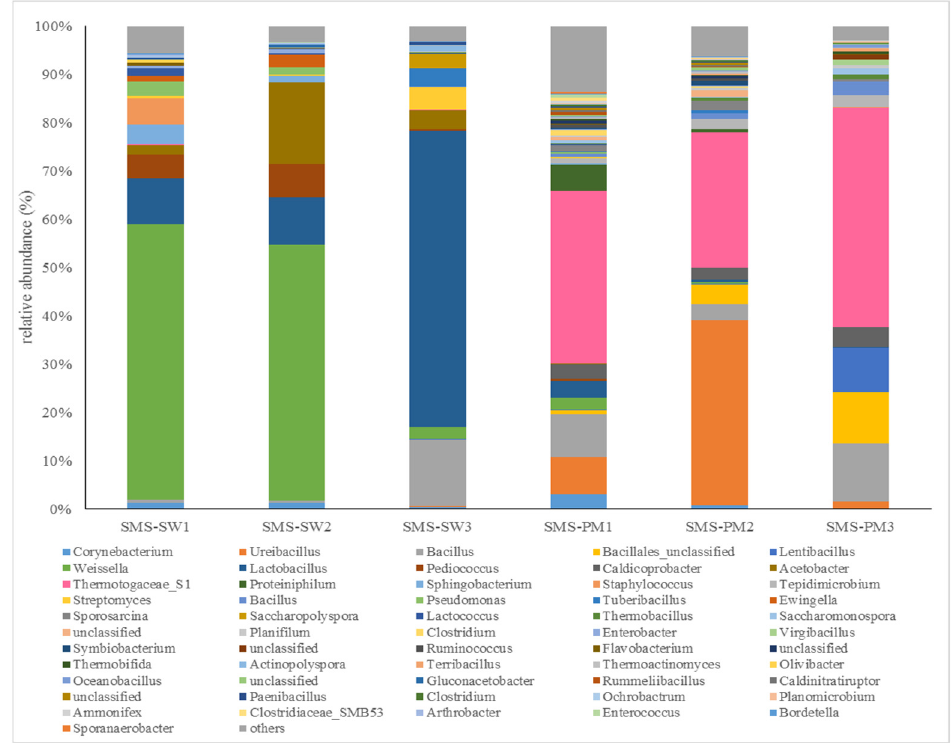
Figure 1. Dynamic changes in the bacterial community at the genus level from spent mushroom substrate with soy wastes (SMS-SW) and with swine and poultry manure (SMS-PW). The relative abundance of genus was >0.1% in at least one sample. Genera with relative abundance <0.1% were grouped as “others”.